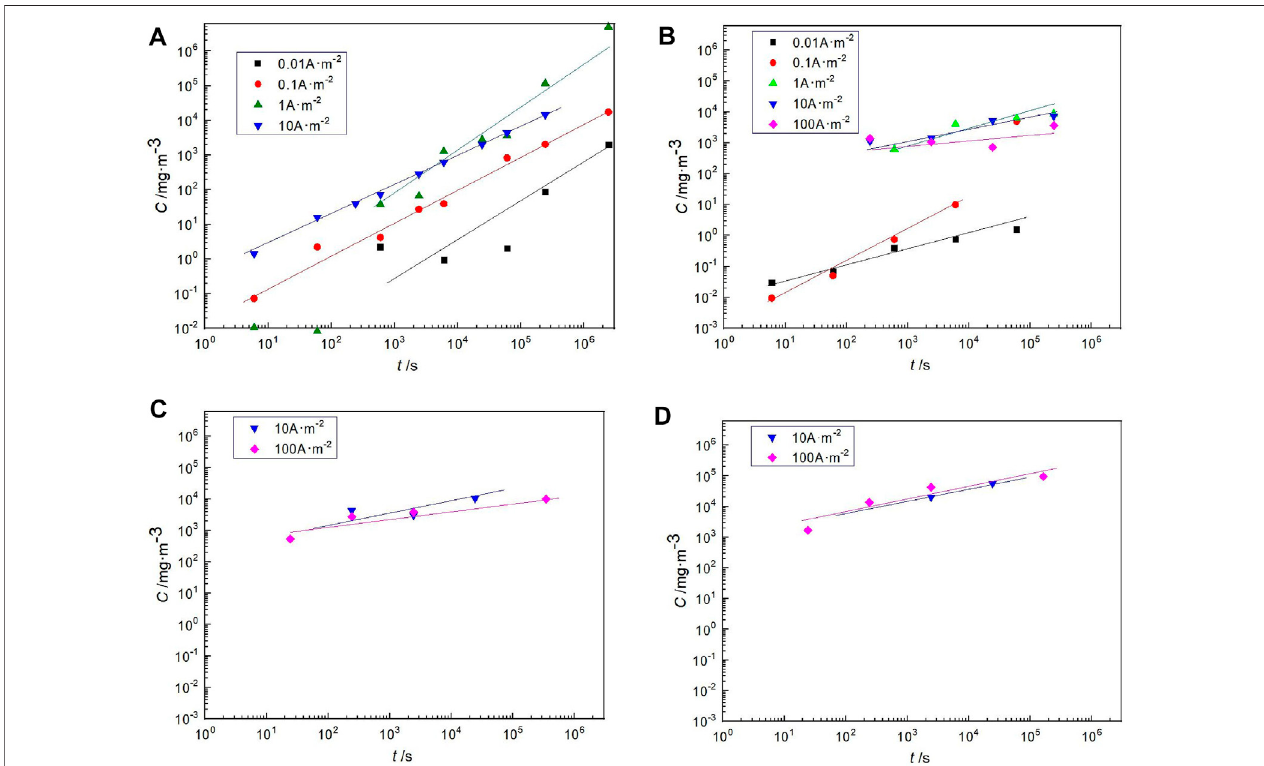
FIGURE 6 | Hydrogen concentration in Q235 steel with different current density of hydrogen charging in saturated highly compacted bentonite at different temperatures; (A) 298 K; (B) 313 K; (C) 351 K; (D) , 363 K.